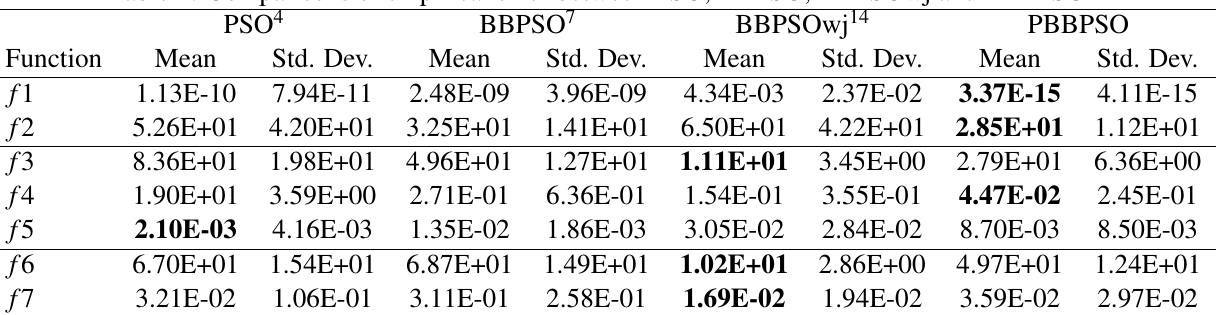
Table 2: Comparisons of empirical error between PSO, BBPSO, BBPSOwj and PBBPSO